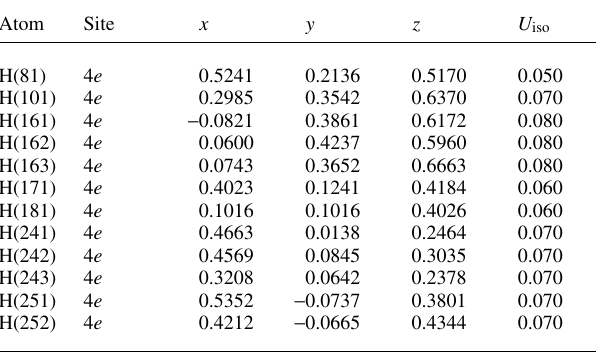
Table 2. Atomic coordinates and displacement parameters (in Å 2 )